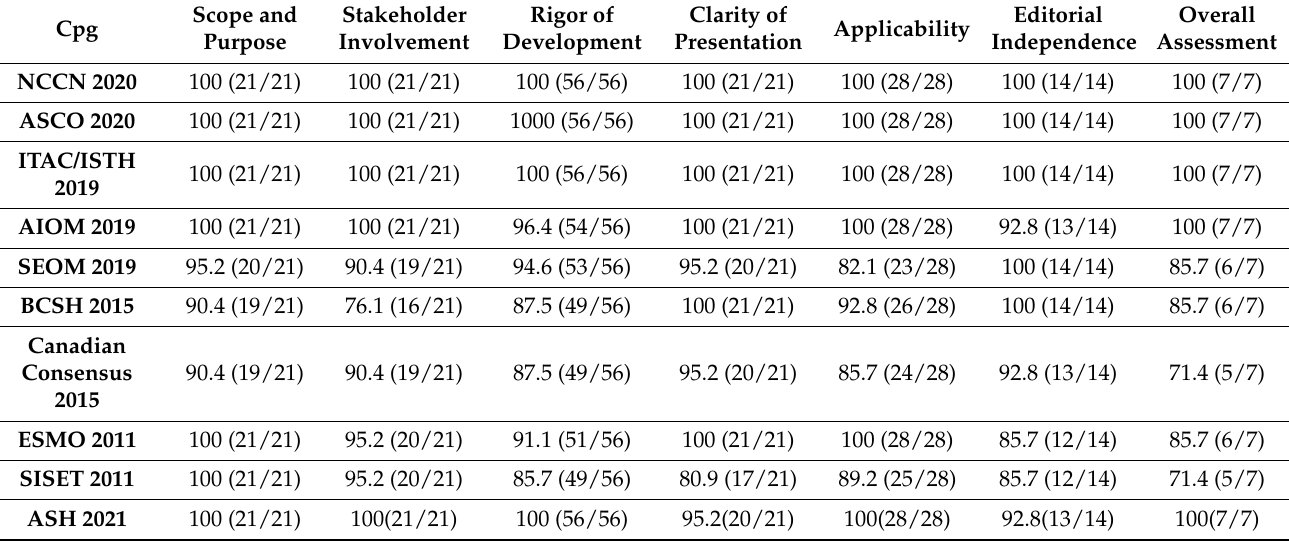
Table 1. AGREE II domain and total score of clinical practice guidelines included in percentage and absolute